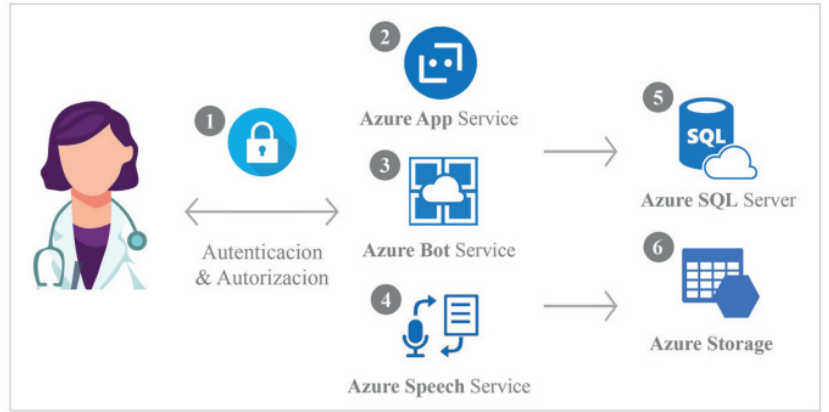
Figure 1. WAY2AGE voice-bot architecture for the piloting (data recruitment) within Azure and its underlying main actions. A digital device is used to activate WAY2AGE by the health professional to implement the cognitive impairment assessment. Image by the company Conectart.